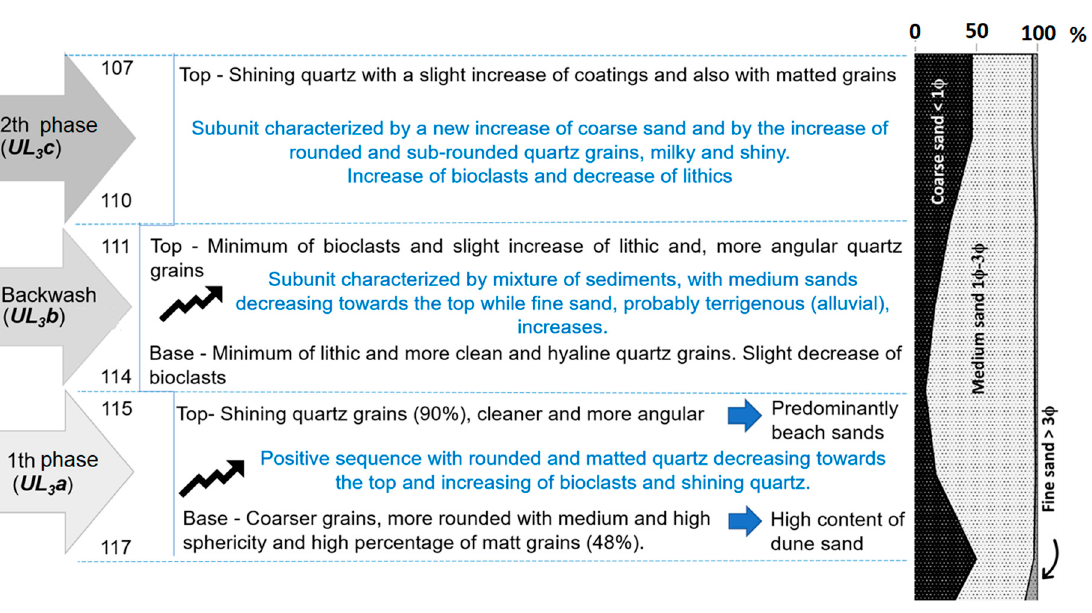
Figure 6. Framework of the morphoscopic and textural characteristics of the quartz grains identified in the three subunits of tsunami deposit.